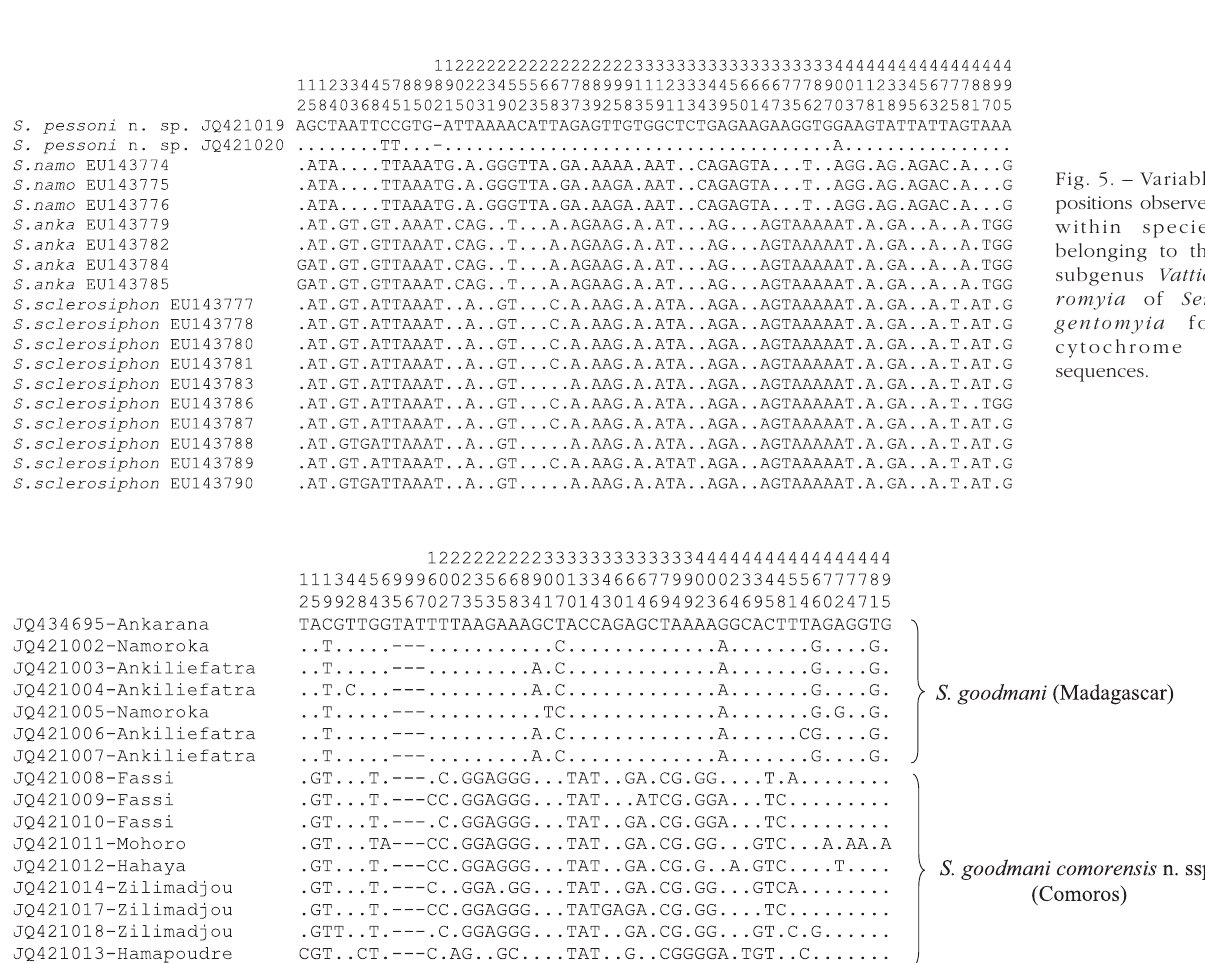
Fig. 6. – Variable positions observed between Sergentomyia goodmani and for cytochrome b